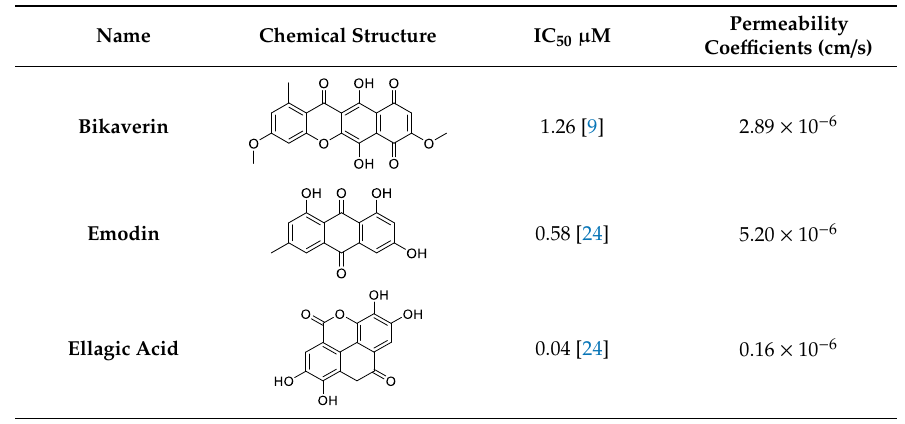
Figure 2. Cell permeability of bikaverin compared to emodin and ellagic acid using a Caco-2 assay based on human epithelial colorectal adenocarcinoma cells. Rhodamine B served as a positive control and FITC-dextran 4 as a negative control. The dotted line indicates the P app limit for a drug that is supposed to be completely absorbed. Table 1. Structures of the tested compounds with their IC 50 values for human CK2 holoenzyme and cell permeability coefficients.